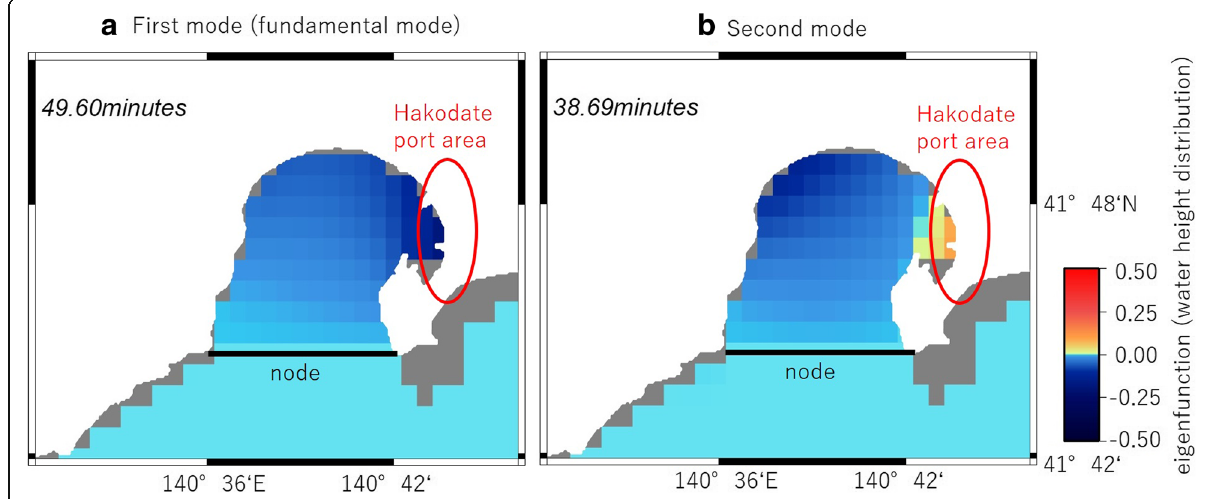
Fig. 6 Eigenfunctions, that is, the spatial distributions of the water heights, and eigen periods of the first mode ( a ), fundamental mode, and second mode ( b ) computed from actual bathymetry for Hakodate Bay. The red ellipse shows the Hakodate port area which is the